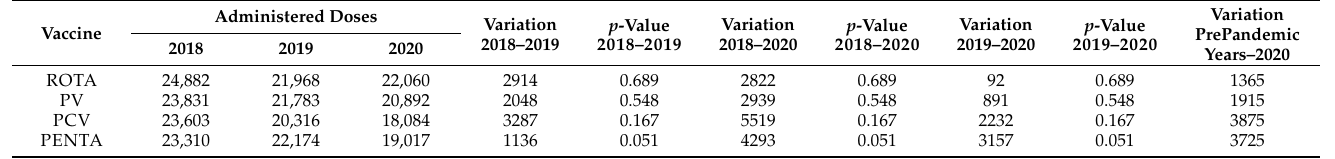
Table 4. Last administered vaccination doses for infants during November 2018–2020 in